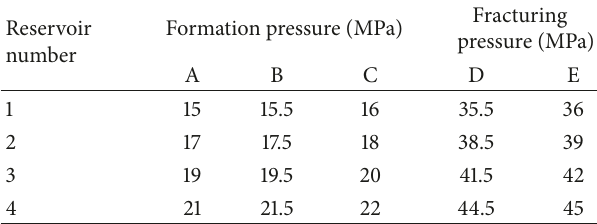
Table 7: The values of formation pressure and fracturing